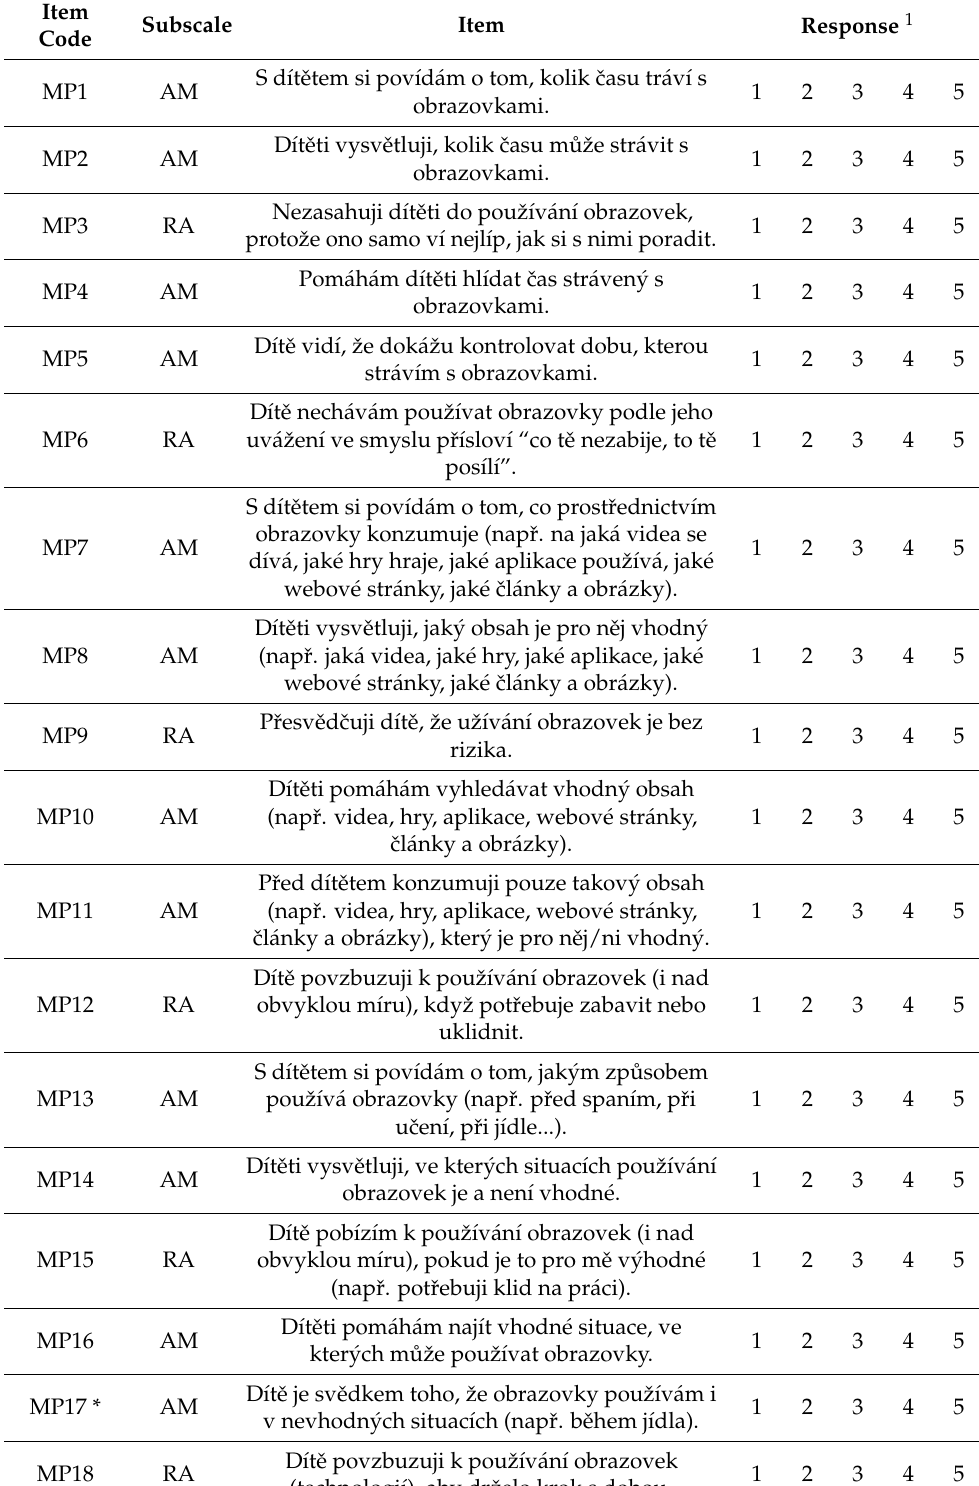
Table A2. MEPA-36: Czech